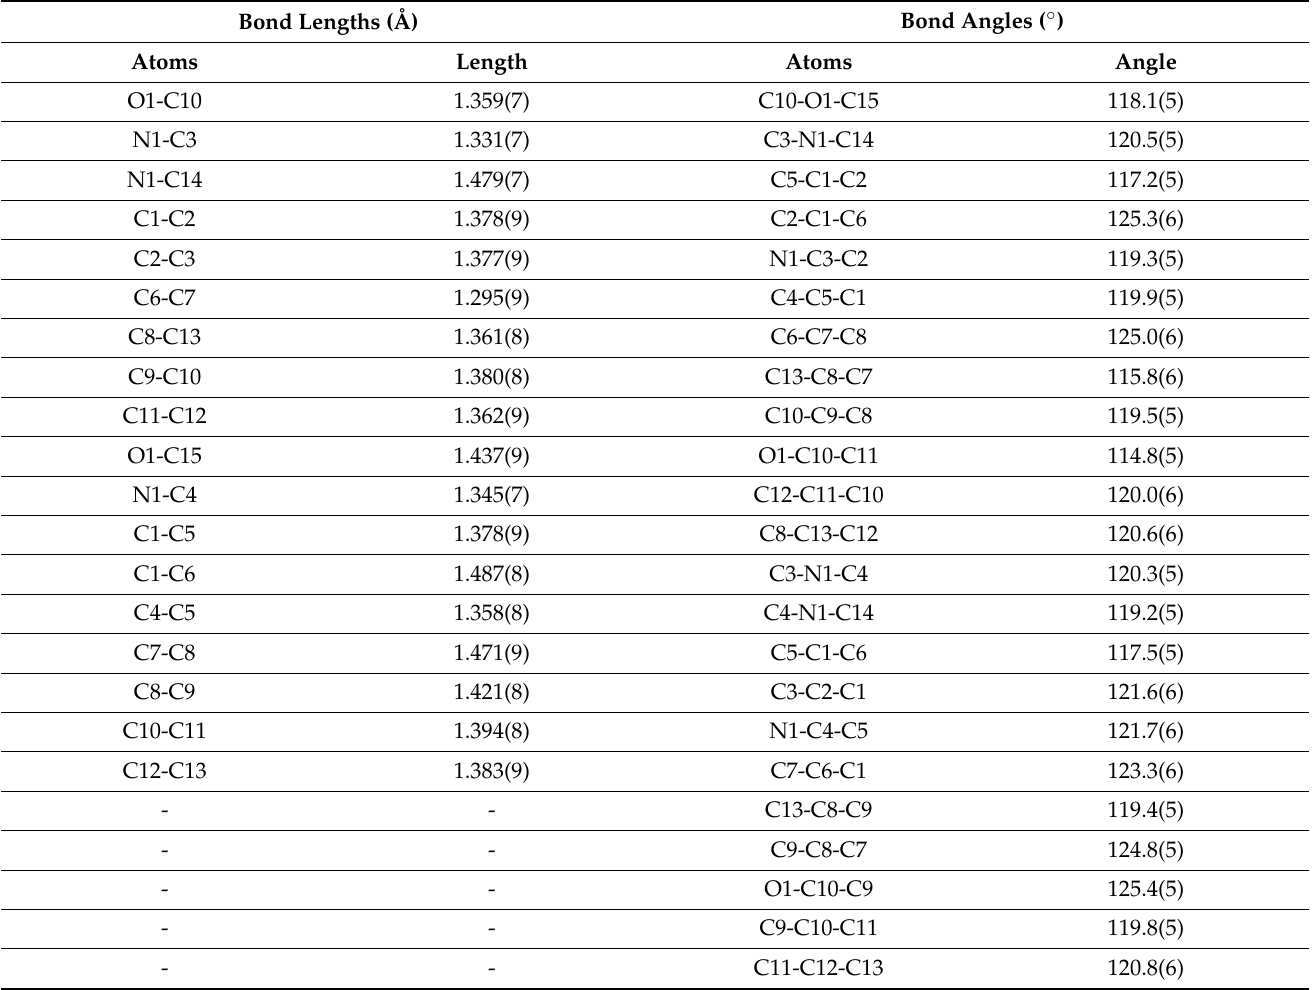
Figure 4. Packing diagram for MMPI. Table 1. Data collection and structure refinement for MMPI crystal.